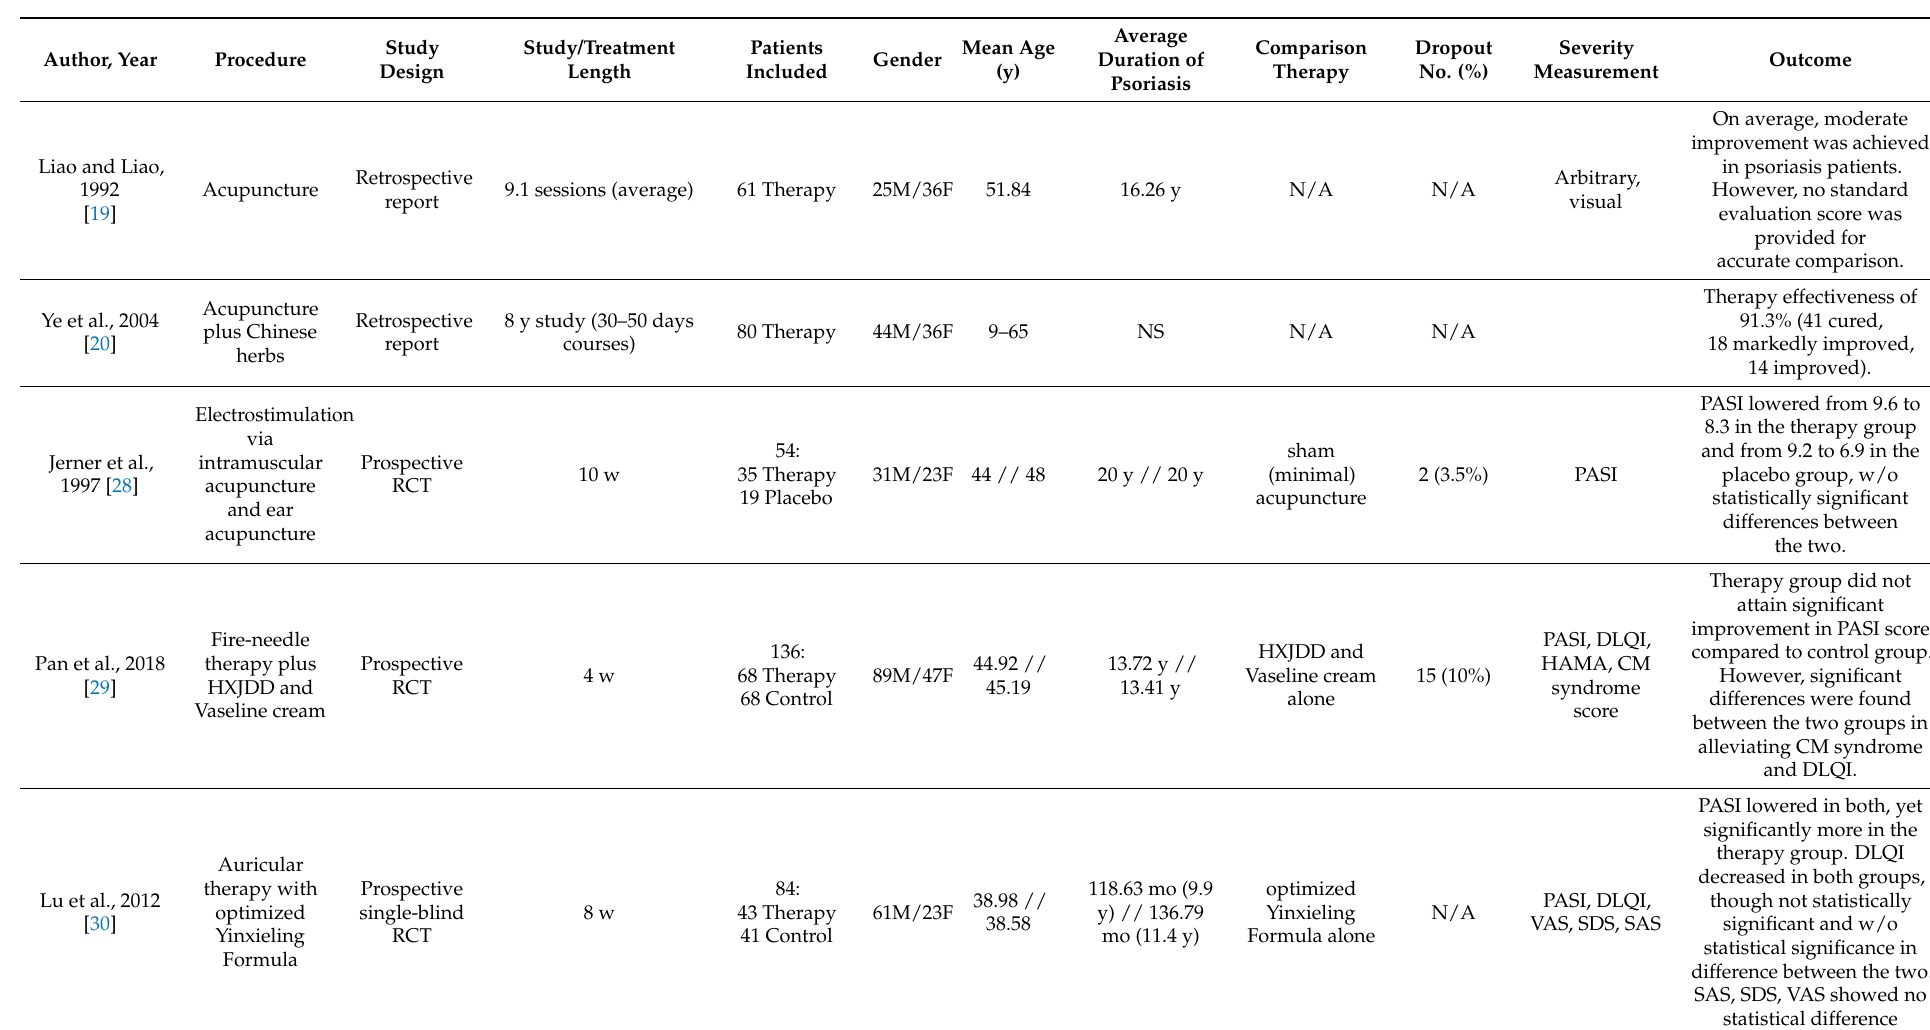
Table 1. Trials and case reports of patients undergoing acupuncture and similar therapies for psoriasis (arranged in order of